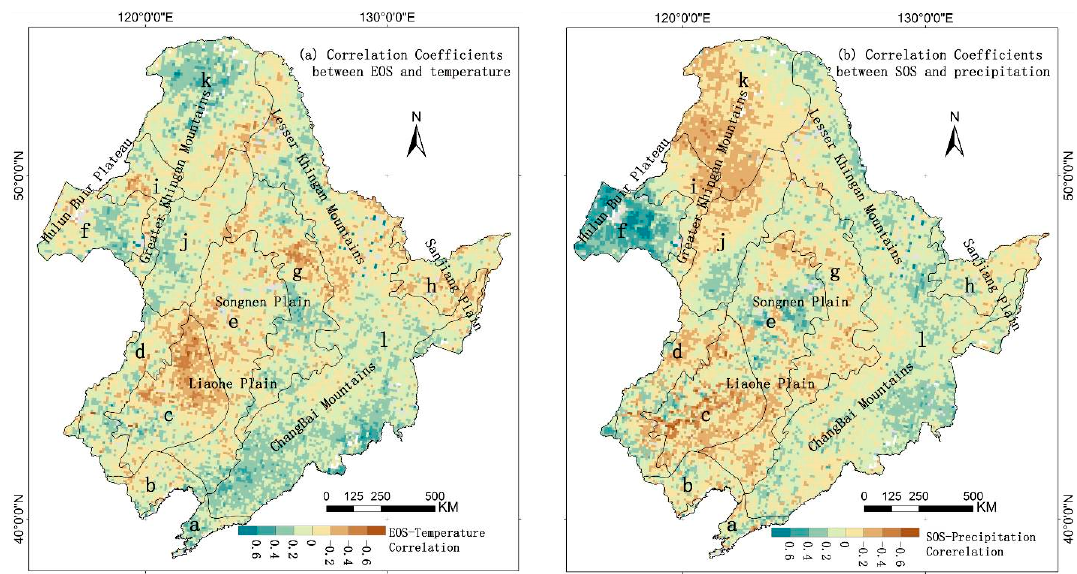
Figure 6. Correlation coefficients between the EOS and temperature ( a ) and between the EOS and precipitation ( b ). Table 3. Percentages of the correlation coefficients between the EOS and temperature and between the EOS and precipitation (Significant Positive Correlation ( r > 0, p < 0.05): No Significant Positive Correlation ( r > 0, p > 0.05), No Significant Negative Correlation ( r < 0, p > 0.05), Significant Negative Correlation ( r < 0, p < 0.05)).